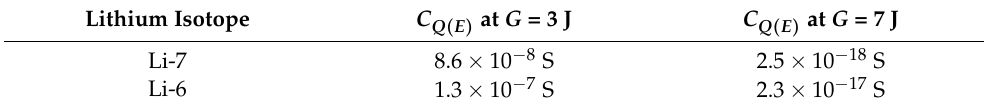
graph (a) of Figure 4.